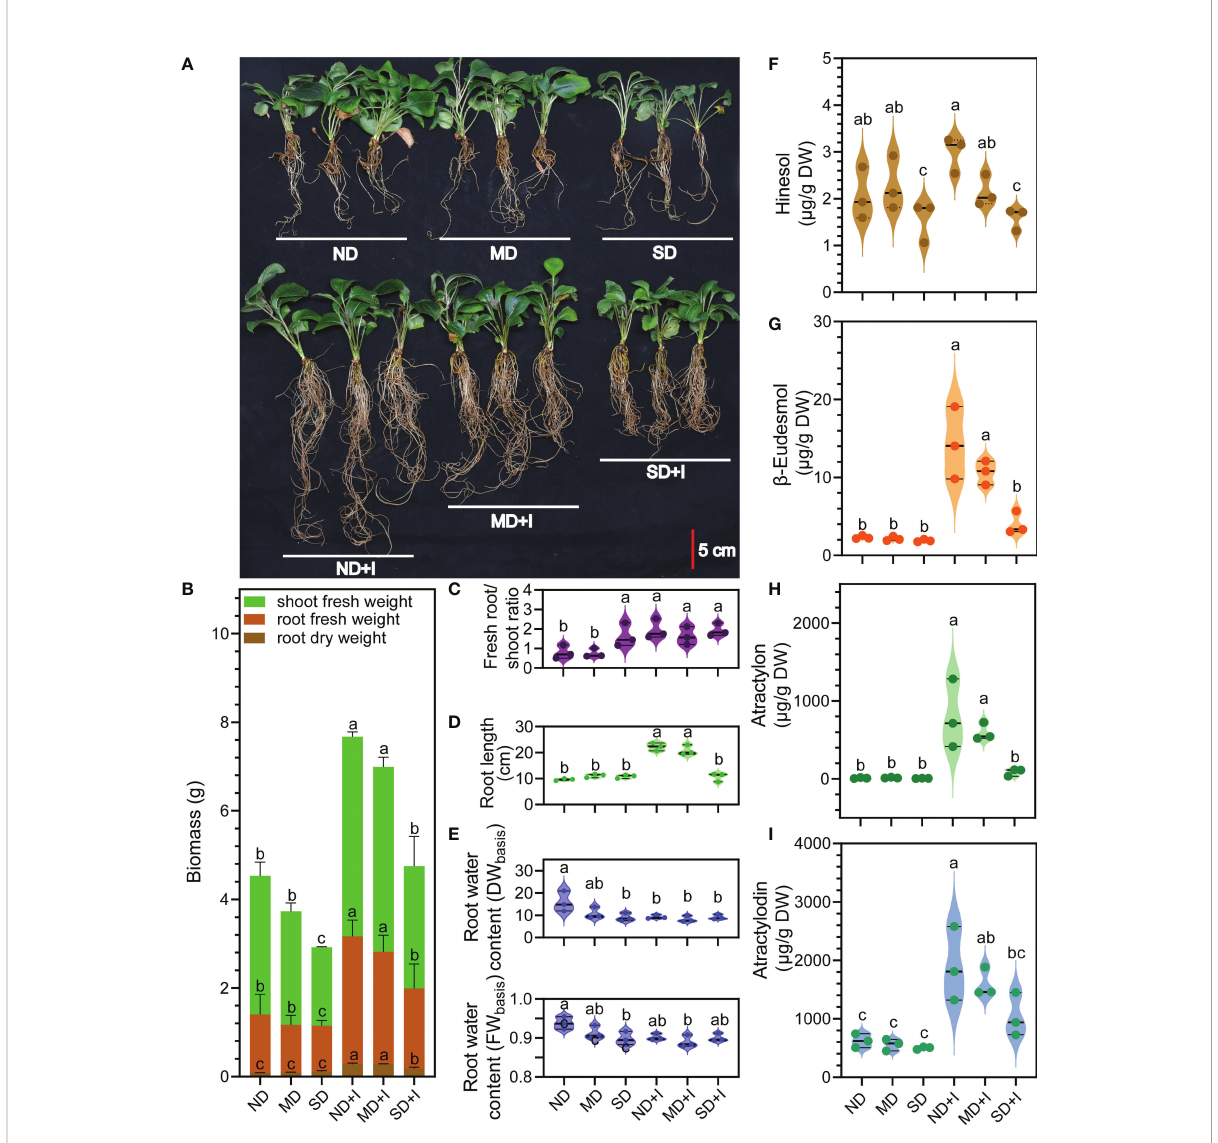
FIGURE 2 Phenotype and concentration of four major medicinal compounds of A lancea under different treatments conditions. (A) Phenotype. (B – I) : n = 3. Data were shown as mean ± SD. Different lower-case letters represent signi fi cant differences (one-way ANOVA, P < 0.05). ND, no drought stress (0% PEG6000); MD, mild drought stress (10% PEG6000); SD, severe drought stress (25% PEG6000); +I, with Geo-authentic soil microbe inoculation; DW, dry weight; FW, fresh